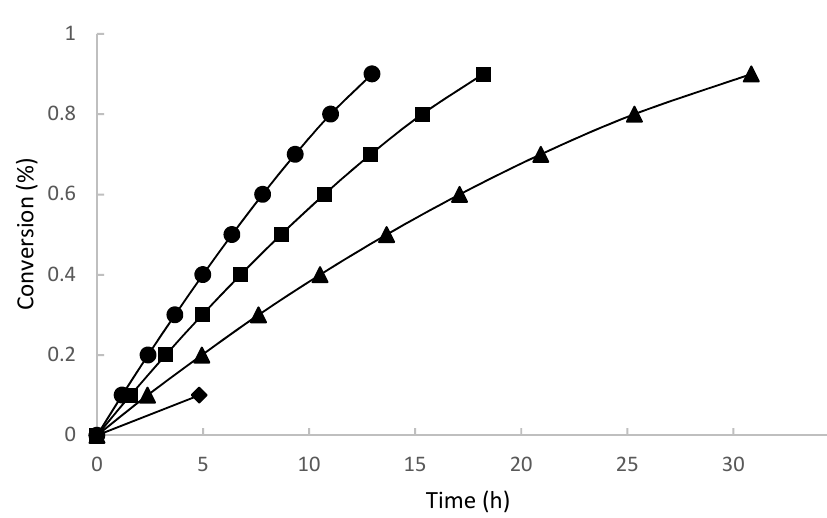
Figure 3. Operation of the enzymatic reactor by sequential batches with monophasic first-order inactivation kinetics, k d = 0.022 (h –1 ). ( ● ) Batch 1; ( ■ ) Batch 2; ( ▲ ) Batch 3; ( ♦ ) Batch 4.